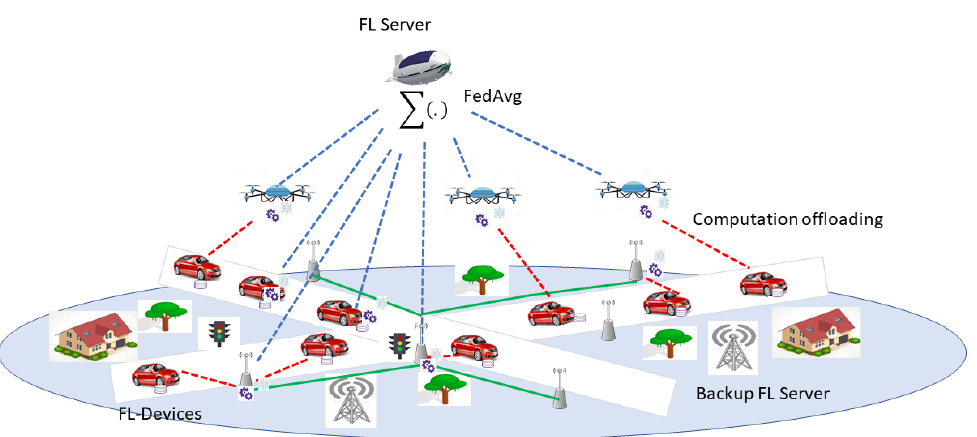
Figure 8. Computation offloading for FL. Reprinted/adapted with permission from Ref. [78]. 2021, Attribution 4.0 International (CC BY